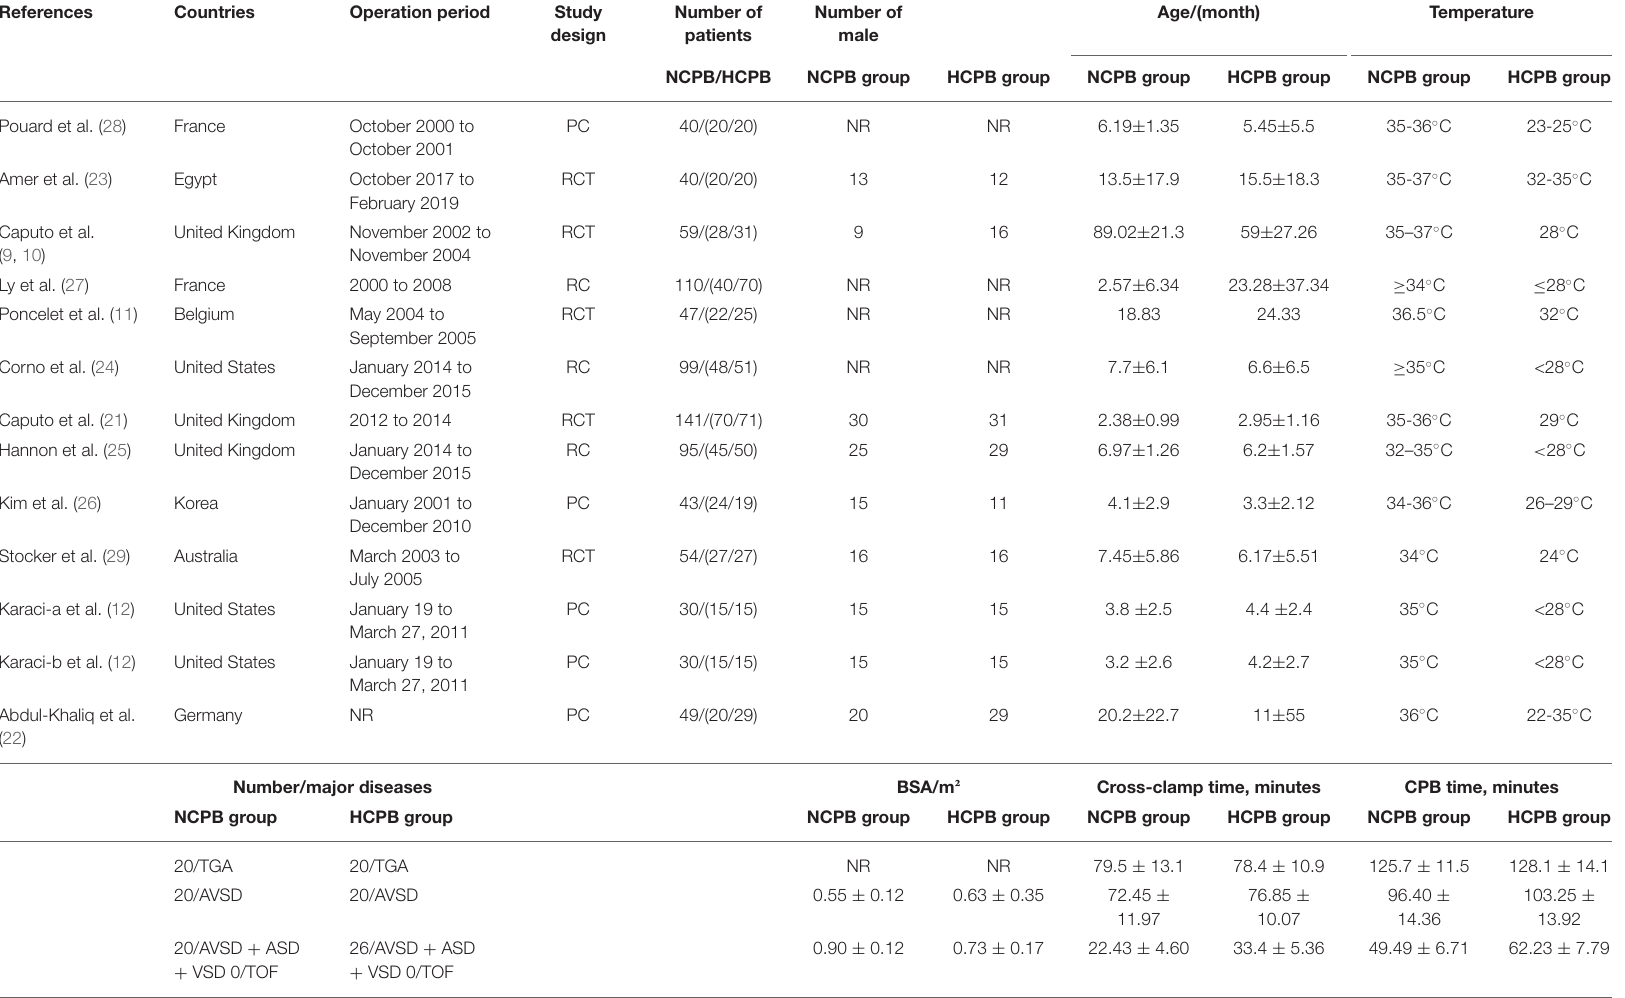
TABLE 2 | Baseline characteristics of individual